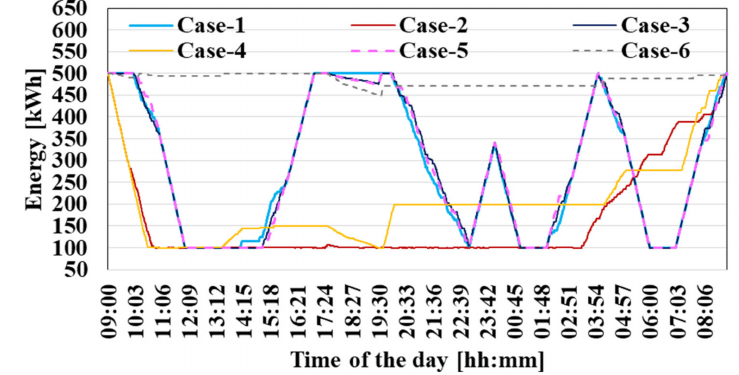
Figure 9. State of energy variation in